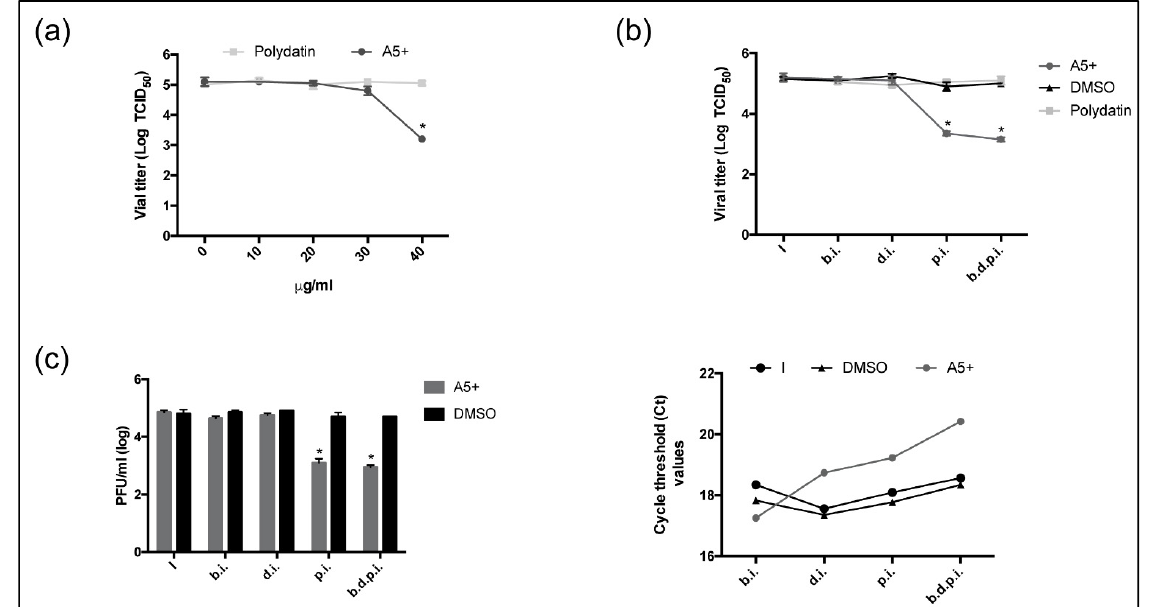
Figure 4. A5+ treatment reduces SARS-CoV-2 replication when added after infection. ( a ) TCID 50 evaluated on supernatants of Vero E6 cells infected with 0.1 MOI of SARS-CoV-2 and treated with different concentrations of Polydatin or A5+ (10 to 40 µg/mL). ( b ) TCID 50 assay on supernatants of Vero E6 infected with 0.1 MOI of SARS-CoV-2 treated with Polydatin (Poly, 40 µg/mL) or A5+ (40 µg/mL) at different steps of viral infection: cells were pretreated with compounds for 2 h at 37 °C before infection (b.i.); the compounds were added during viral challenge (d.i.) or immediately after infection (p.i.); the compounds were added overtime (before, during and post infection, b.d.p.i). DMSO was used at the same conditions in infected as control (I). ( c ) Viral titer measured in the supernatants of cells treated with A5+ (40 µg/mL) at the same conditions reported in ( b ) and expressed as plaque forming units (PFU/mL) assay (left graph) or cycles threshold (Ct) obtained by Real-Time PCR analysis (right graph). (* p < 0.05). TCID 50 : Tissue Culture Infectious Dose 50%; DMSO: dymethylsulfoxide; PFU: plaque forming units.